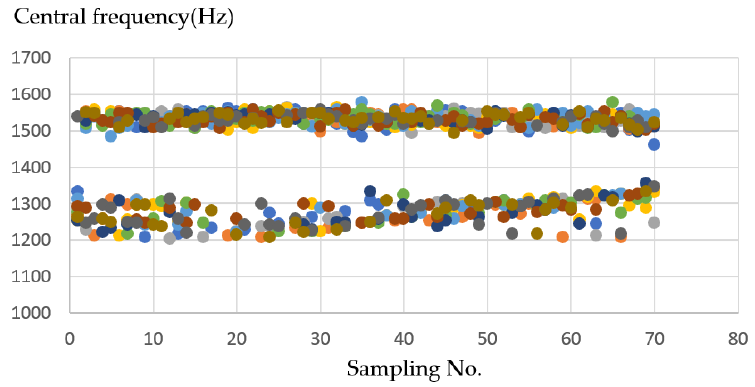
Figure 12. Ten sample frequency results from clustering by K-means for the XZ axes.